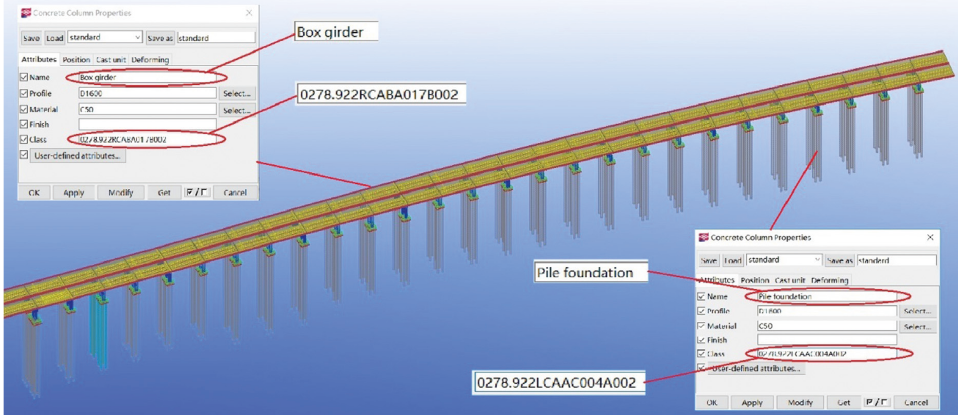
Figure 7: Typical EBS coding results of Ou River Estuary southern approach to span